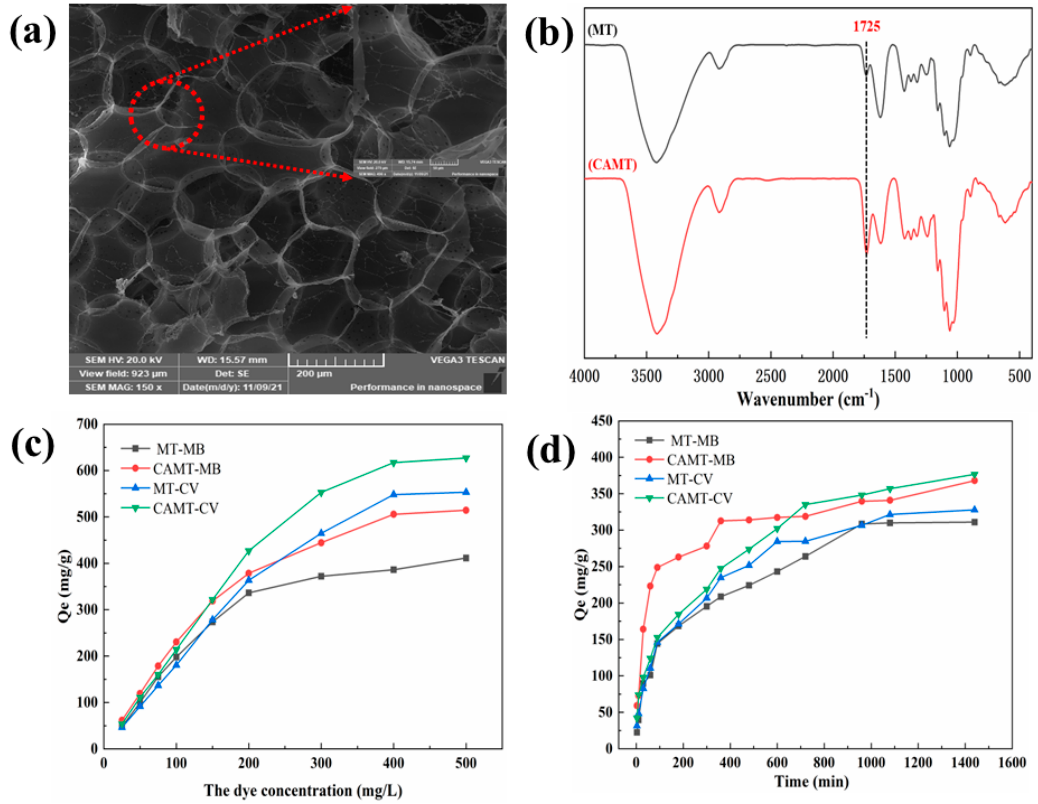
Figure 10. ( a ) SEM image of CAMT. ( b ) FTIR spectra of MT and CAMT. ( c ) Effect of initial concen- tration of dye on the performance of MT and CAMT. ( d ) Effect of adsorption time on the perfor- mance of MT and CAMT.